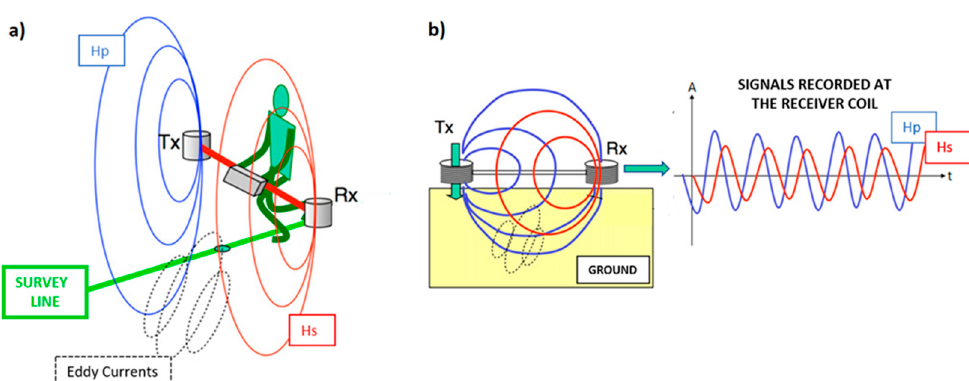
Figure 3. ( a ) Schematic representation of an frequency-domain electromagnetic (FDEM) device. A transmitter coil (Tx) emits a transient primary magnetic field (Hp—blue line) that induces eddy currents (dotted lines) in the ground. These eddy currents generate a secondary electromagnetic field (Hs—red line). ( b ) Hp and Hs are recorded by the receiver coil (Rx). Note that Hp and Hs have amplitude and phase lag [59].